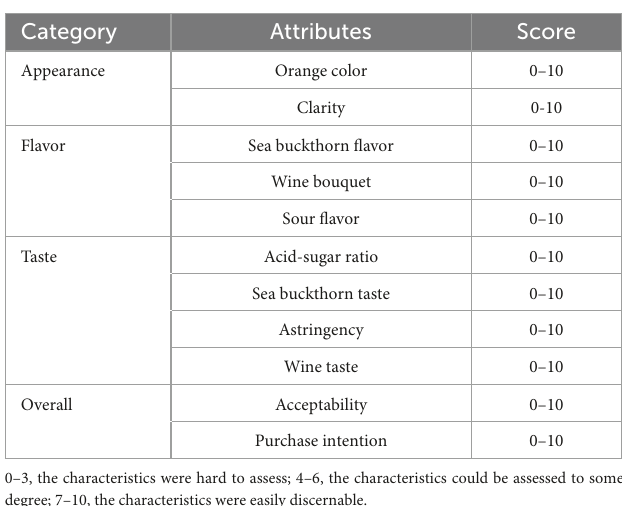
Table 4 . The regression model optimized here was highly significant ( p < 0.01), whereas the lack of fit was not ( p > 0.05). Meanwhile, the model regression coefficient R 2 of the SOD activity was 0.9835, while and the model regression coefficient R 2 of TFC was 0.9598, showing TABLE 7 Sensory attributes of the fermented sea buckthorn juice